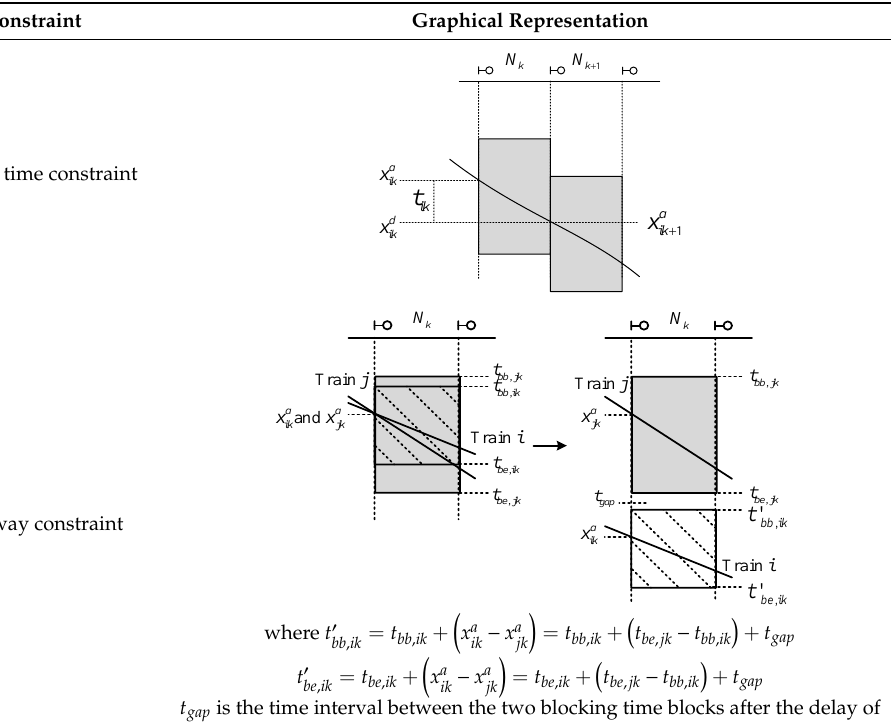
Table 5. Constraints of the capacity evaluation model.